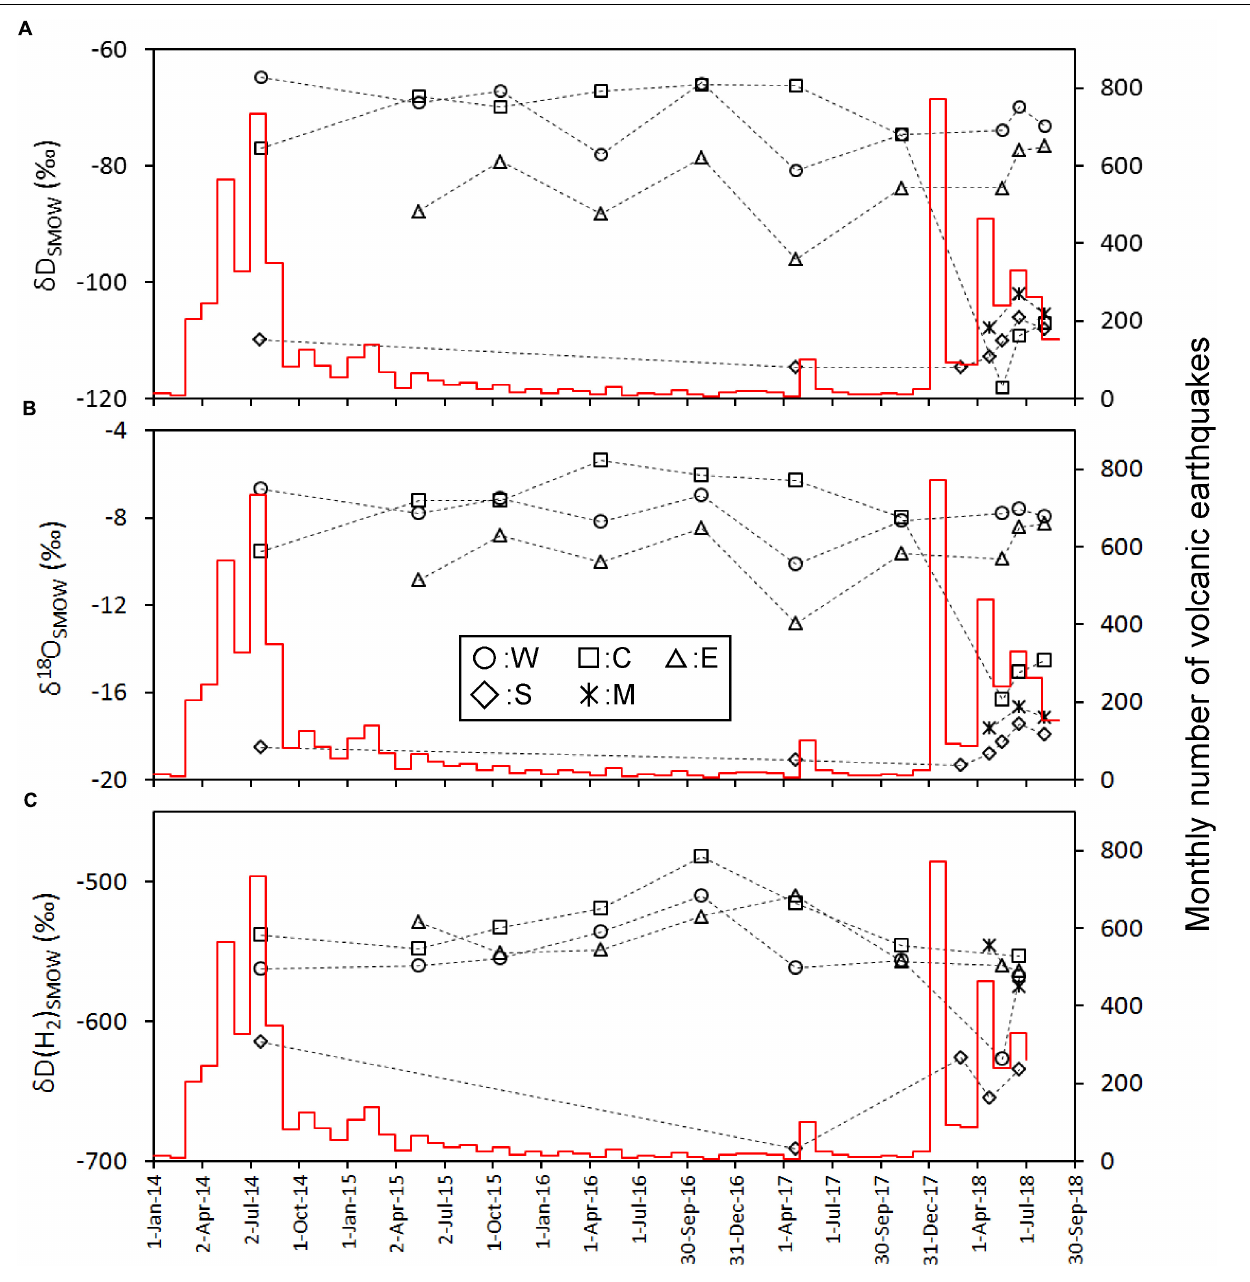
FIGURE 4 | Time variation of δ D(H 2 O) (A) , δ 18 O(H 2 O) (B) , and δ D(H 2 ) (C) calibrated on the left y -axis. The red histogram calibrated on the right y -axis shows the monthly number of volcanic earthquakes observed by JMA.